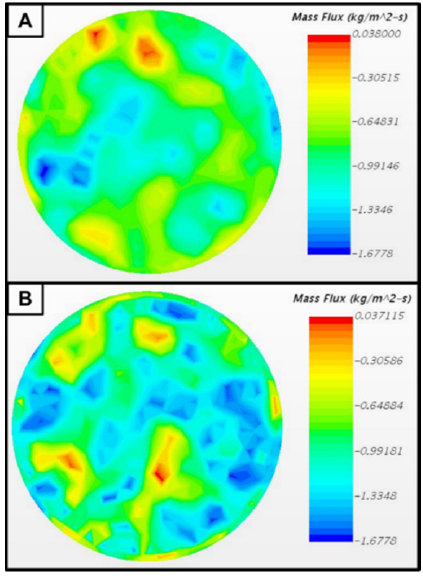
Figure 6. Simulation results of ammonia uniformity in the catalyst inlet: ( A ) L-type urea injector and ( B ) I-type urea injector.